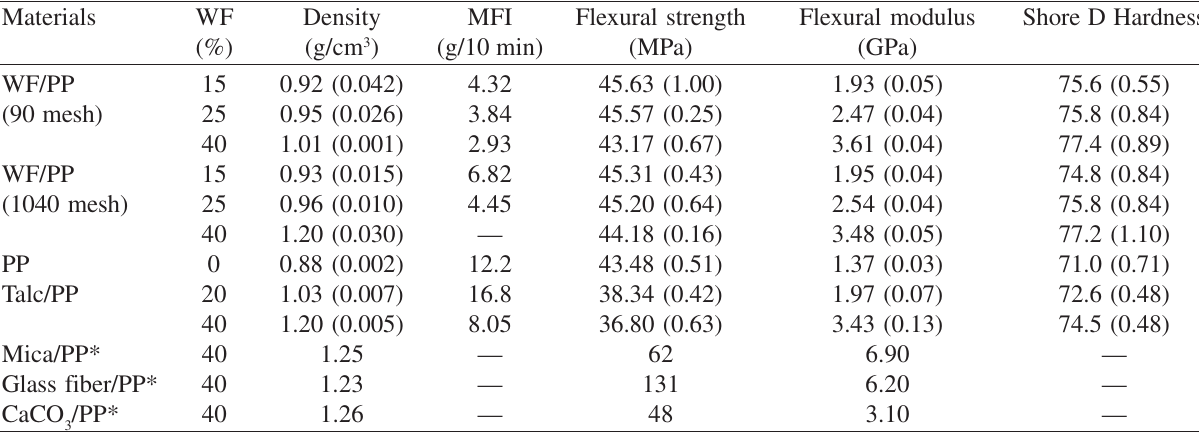
Table 2. Effect of woodflour contend and filler granulometry on the physical properties of WF/PP composites (comparison with data on commercially available polypropylene and composites); their respective values for standard deviations are in parenthesis.